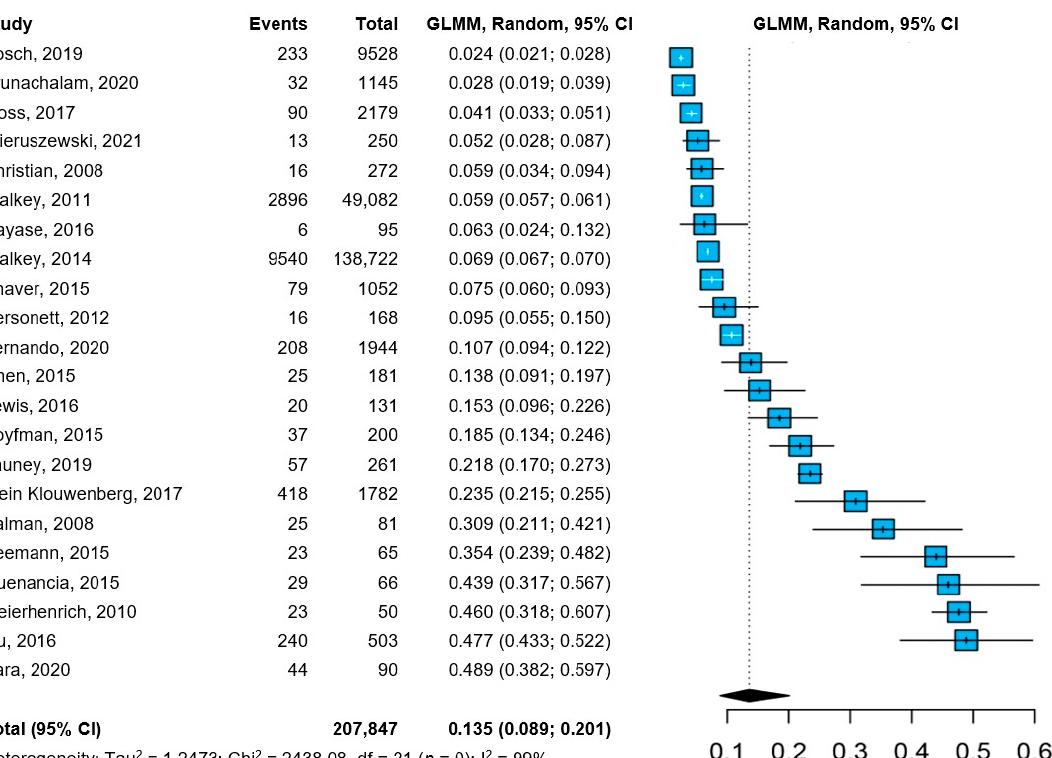
Figure 1. Pooled prevalence of NOAF in patients with sepsis [12,18–38]. Abbreviations: CI = confi- dence interval; GLMM = generalized linear mixed model; NOAF = new-onset atrial fibrillation; I 2 = inconsistency index.